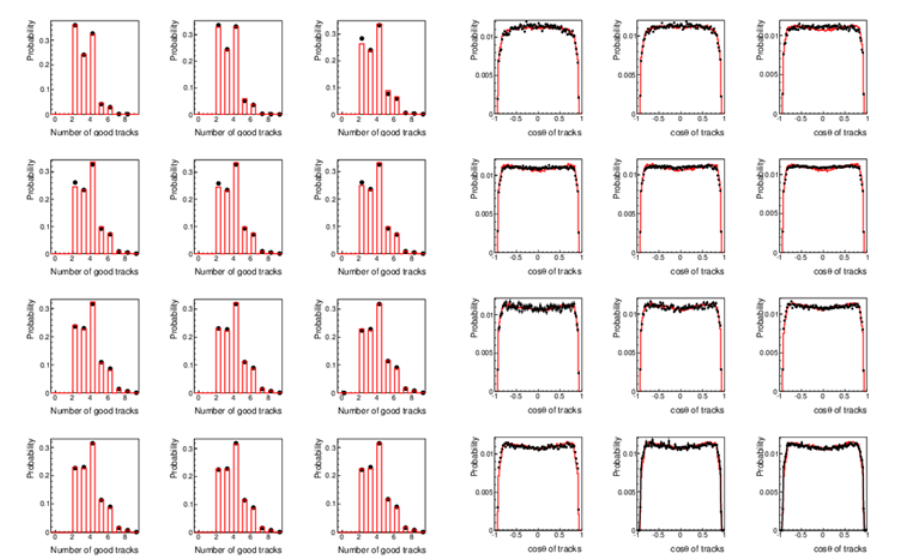
Figure 5. The distributions for multiplicity (left) and cos θ of charged track (right), the black points are distribu- tion of experimental data, where contribution from background events are already subtracted, the red histogram are obtained by ConExc